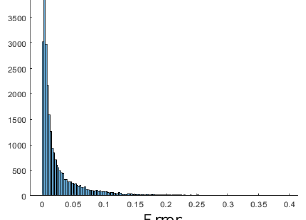
Figure 3. Histogram of plane fitting error.